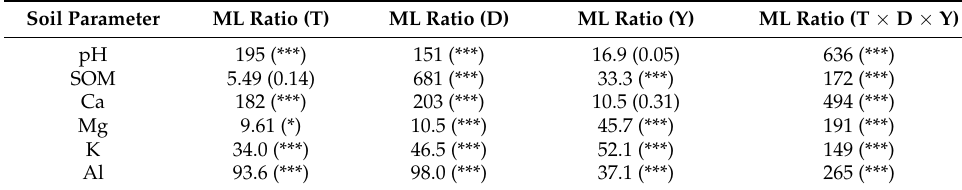
Table 4. Analysis of variance performed on soil parameters (pH, SOM, Ca, Mg, K and Al). The variability in the soil parameters was evaluated using the hierarchical multilevel model (maximum likelihood (ML) ratio). The results were significant at * p < 0.05 and *** p < 0.001. Soil Parameter ML Ratio